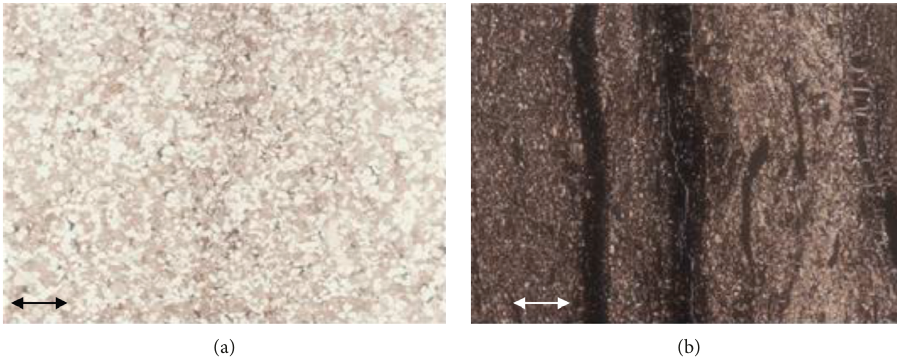
Figure 8: Scanned thin section images. The arrow length is 2mm. (a) Mchenga arkose sandstone. (b) Mchenga fine-grained